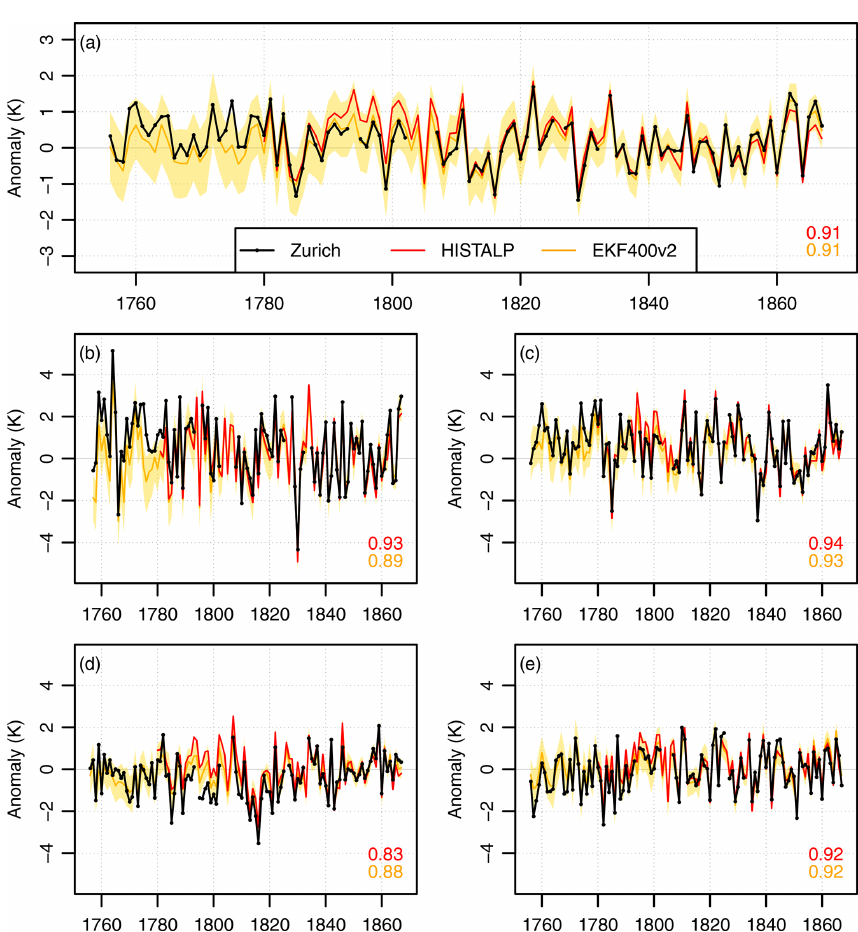
Figure 12. (a) Annual temperature series for Zurich and for the nearest grid point of the HISTALP and EKF400 data sets, expressed as anomalies with respect to the period 1801–1850. The shading represents the ensemble spread in EKF400. The same is also shown for (b) December–February, (c) March–April, (d) June–August, and (e) September–November. Pearson correlation coefficients between Zurich and the other data sets are also